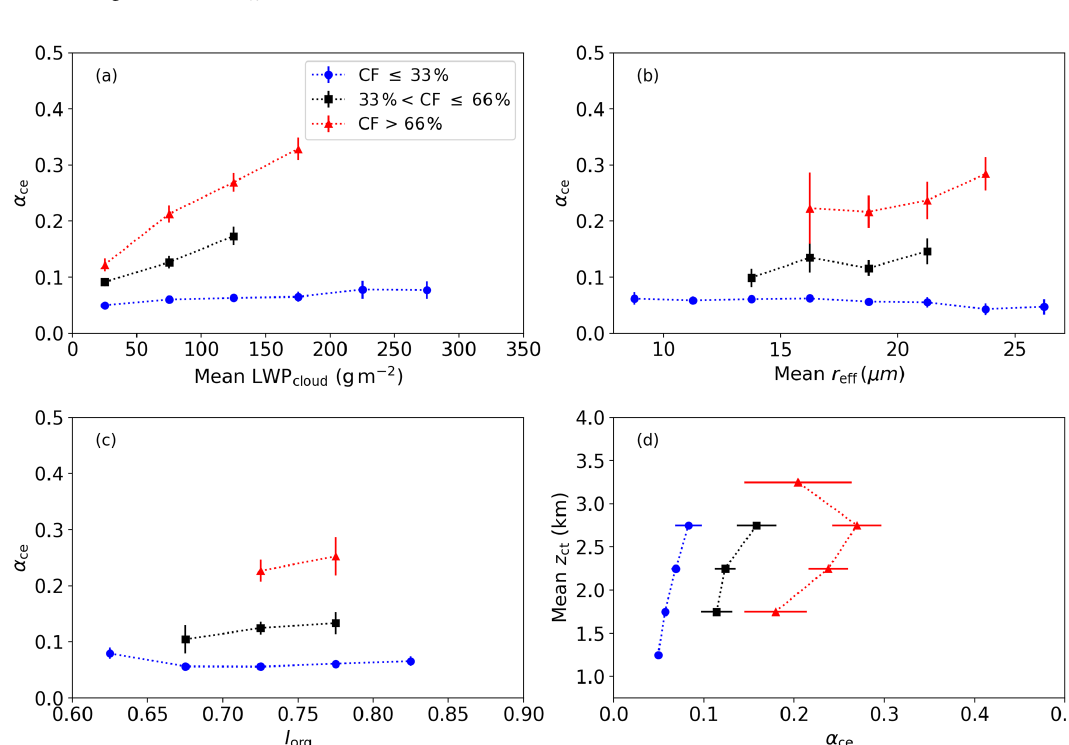
Figure 7. The relationship between α ce and different cloud properties also as a function of different cloud fraction classifications. (a) LWP cloud , (b) r eff , (c) I org and (d) z ct . The bars indicate 95% confidence